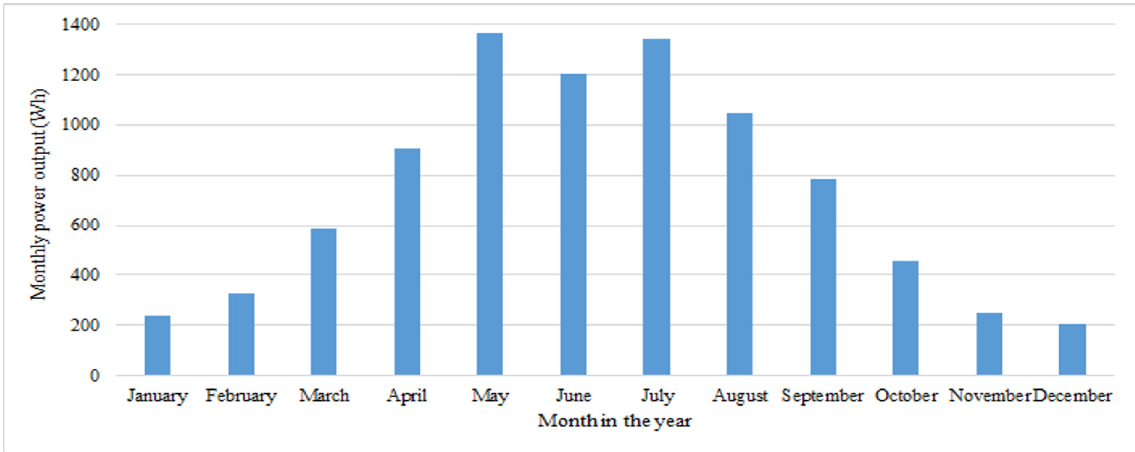
Figure 7. The amount of electricity produced in each month of the year.